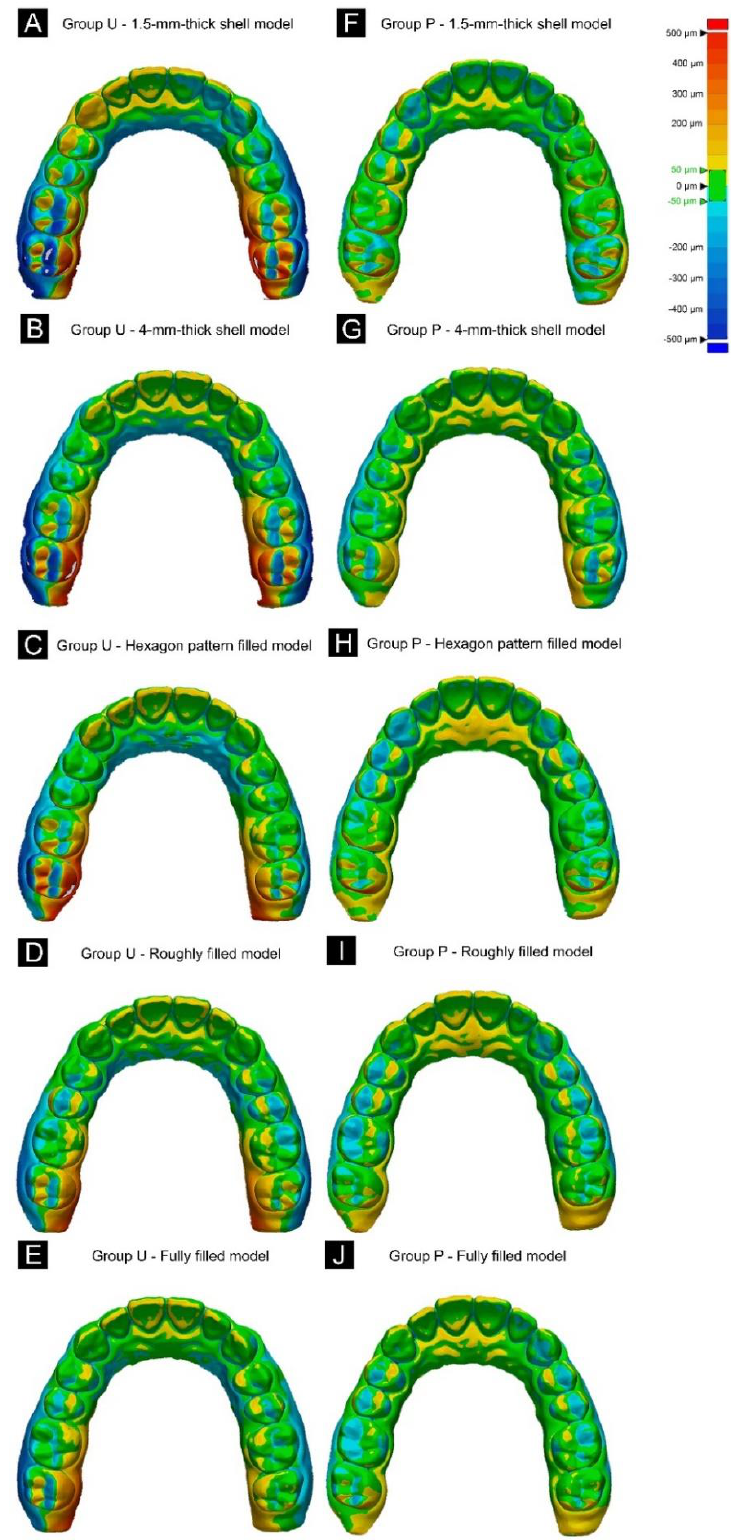
Figure 8. 3D color maps of the trueness in ( A – E ) Groups U and ( F – J ) P. The contraction occurred mainly in the lingual direction in the posterior region in Group U, whereas the overall model was stable in Group P. ( A , F ) 1.5mm-thick shell model. ( B , G ) 4mm-thick shell model. ( C , H ) Hexagon pattern filled model. ( D , I ) Roughly filled model. ( E , J ) Fully filled model.